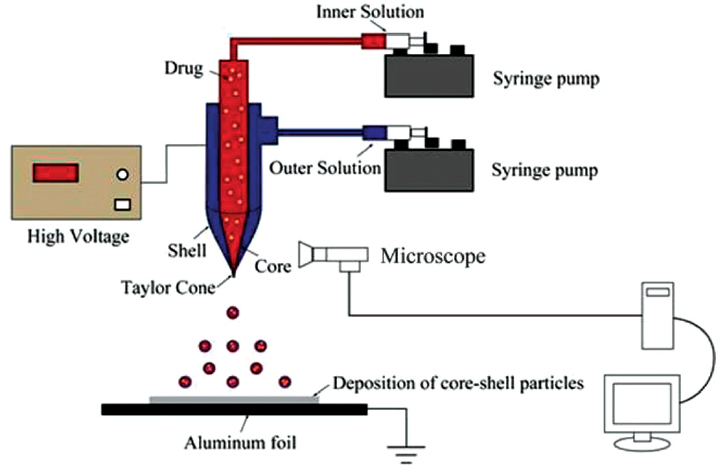
Figure 4. Experimental setup for preparing core-shell nanoparticles (Adapted from [49]).